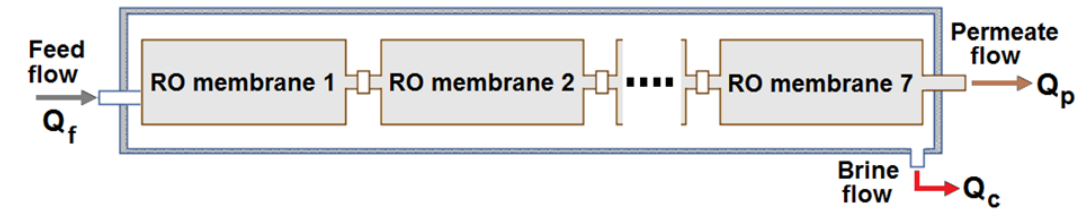
Figure 6. Schematic of a single pressure vessel containing seven aromatic polyamide membranes.